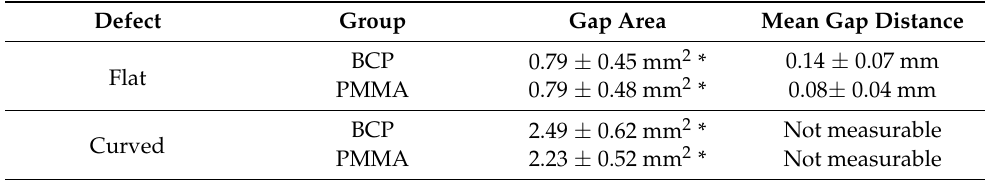
Table 2. The area of internal gap between the block and defect measured in the cross-sectional scanning electron microscope